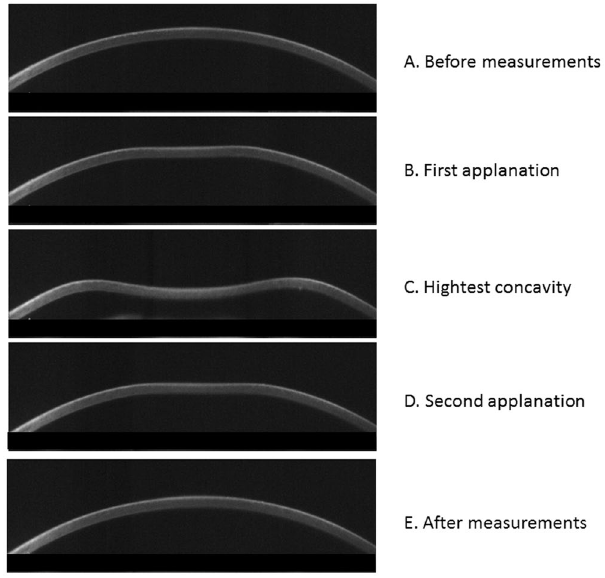
Figure 2. Corneal movement during the CST measurement. In the CST tonometry measurement, a rapid air puff is applied to cornea and cornea moves inward. The figures show the corneal shape in each phase: ( A ) Prior to air puff applanation, ( B ) first applanation, ( C ) highest concavity, ( D ) second applanation, and ( E ) posterior to air puff applanation. CST: Corvis ST